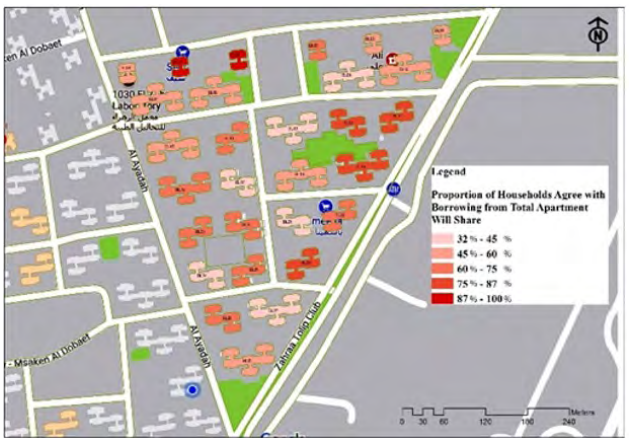
Figure 19. Proportion of households agree with banking borrowing from the total apartment will share in the